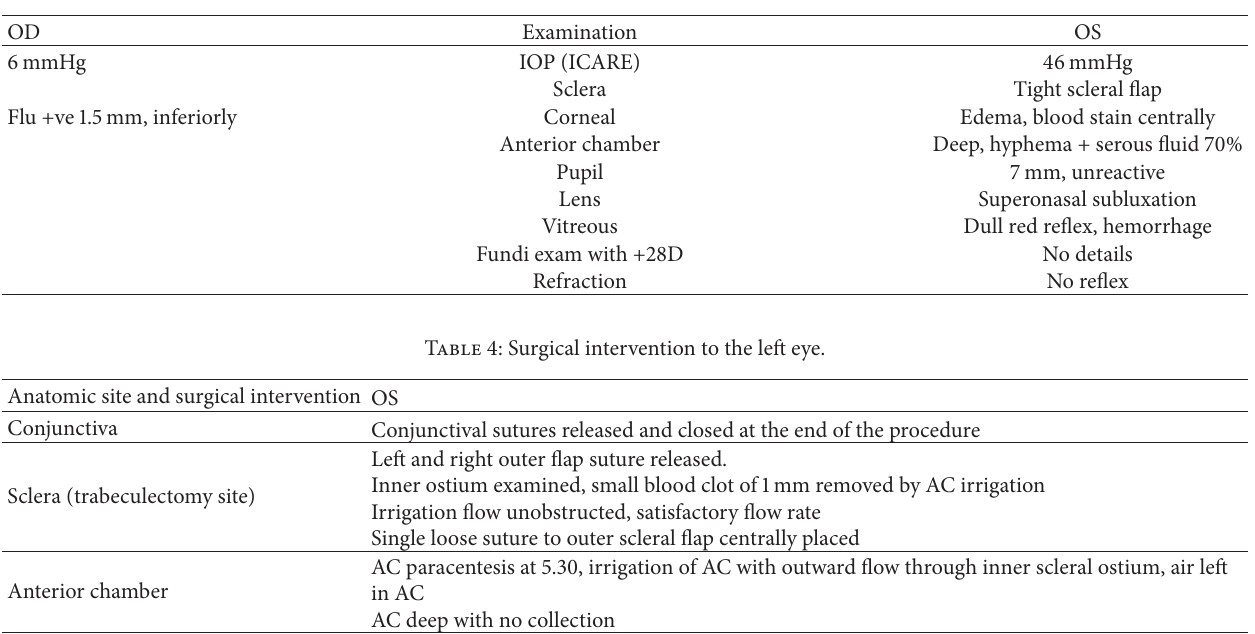
Table 3: Results of EUA performed 48 hrs after surgery.